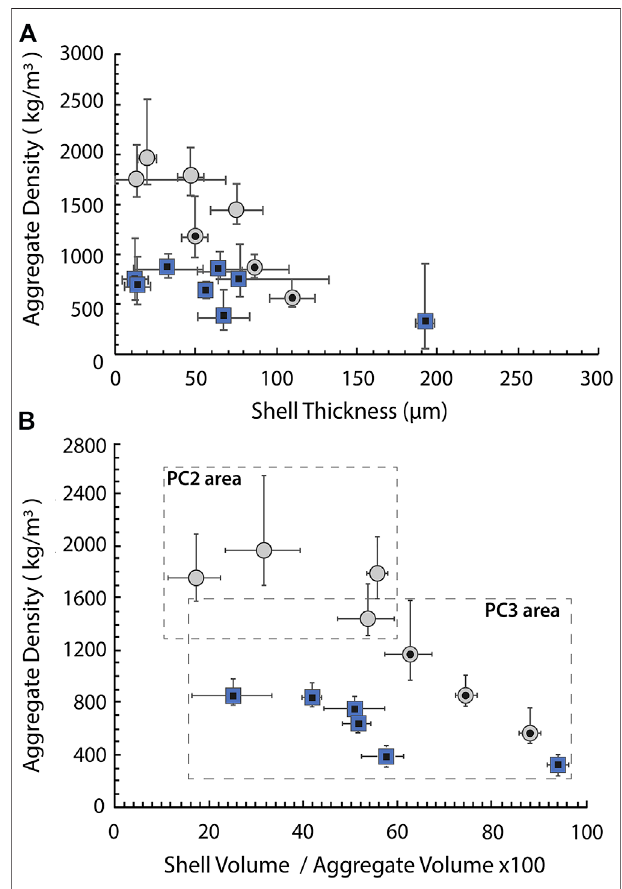
FIGURE 7 | Comparison between the derived aggregate density and quantities related to the aggregate structure (i.e., shell volume and thickness, aggregate volume): gray circles and blue squares refer to aggregates collected on August 2 – 3, respectively; empty symbols indicate PC2 aggregatesandsymbolswithblackinternalmarkersindicatePC3aggregates. In (A) the thickness of the shell (i.e., fi ne ash layer coating the core) is compared with the aggregate density, while in (B) the relative volume of the shell is compared with the aggregate density. The two dashed rectangles represent the fi elds of existence of the measured PC2 and PC3 aggregates in terms of density and relative volume of shell.